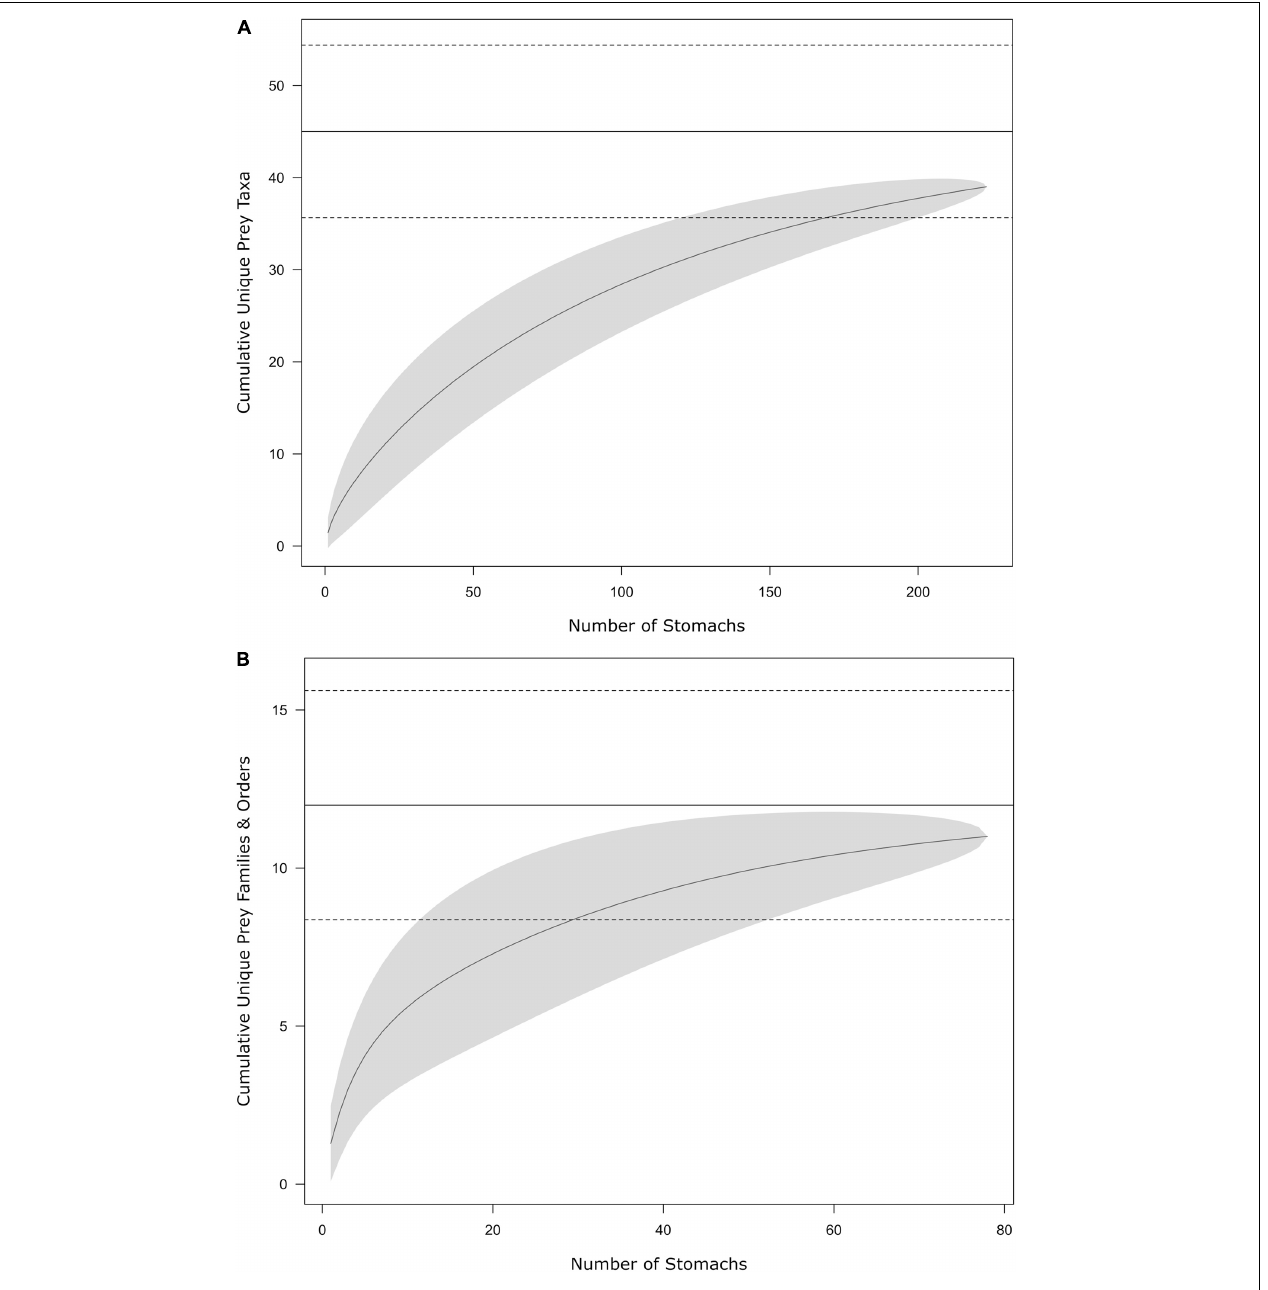
FIGURE 2 | Cumulative prey curves of the diet of juvenile bull sharks from nwGoM estuaries for prey identified to (A) the lowest possible taxon and (B) family level or higher. Horizontal solid lines represent estimated mean asymptotic prey richness ± 95% confidence intervals (dotted lines) against the number of stomachs examined. Solid curve lines represent mean prey richness. Shaded contours represent 95% confidence intervals of prey